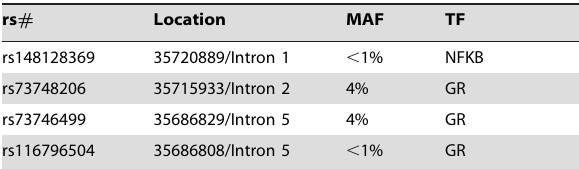
SNPs selected for functional genomic